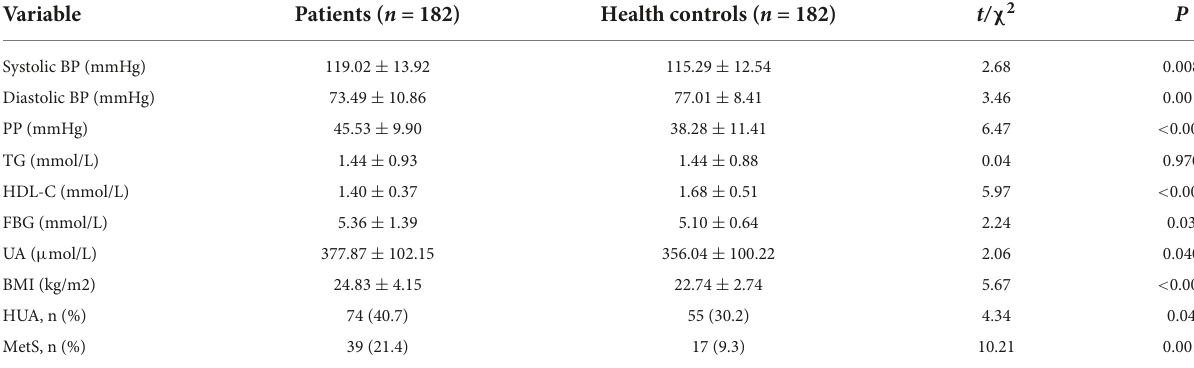
TABLE 2 Clinical characteristics of BPD and health controls.